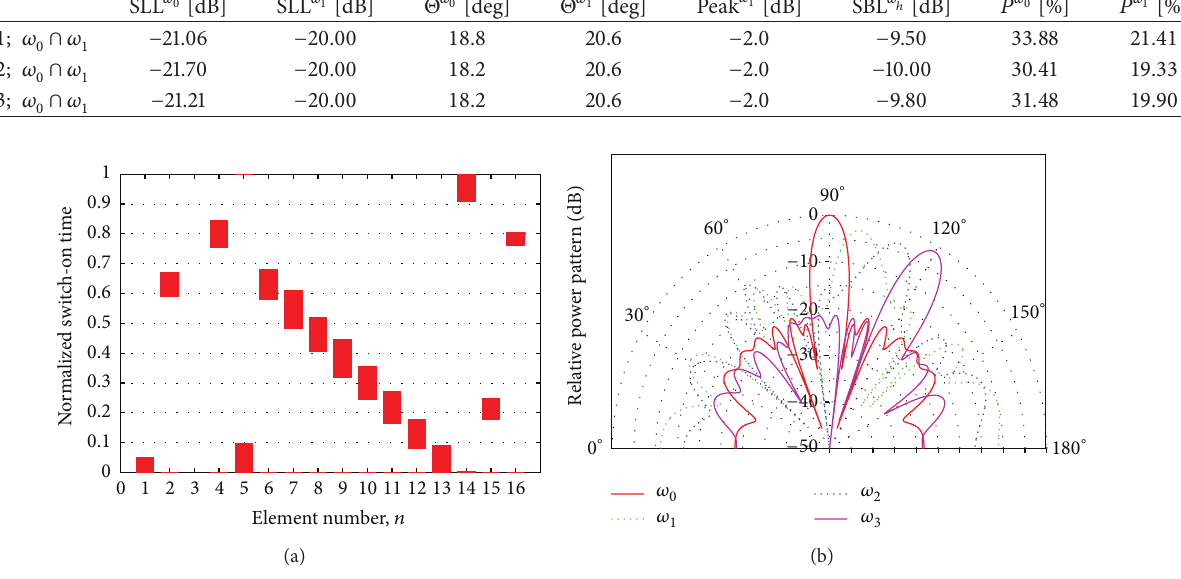
Figure 4: Single-pulse waveform, 𝑄 = 1 —multibeam sum pattern synthesis at 𝜔 0 and 𝜔 3 ( 𝑁 = 16 ; 𝑑 = 𝜆/2 ; 𝜃 𝜔 0 = 90 ∘ ; 𝜃 𝜔 3 = 120 ∘ )—plot of (a) the optimized pulse sequence and (b) corresponding power patterns generated at 𝜔 0 , 𝜔 1 , 𝜔 2 , and 𝜔 3 .